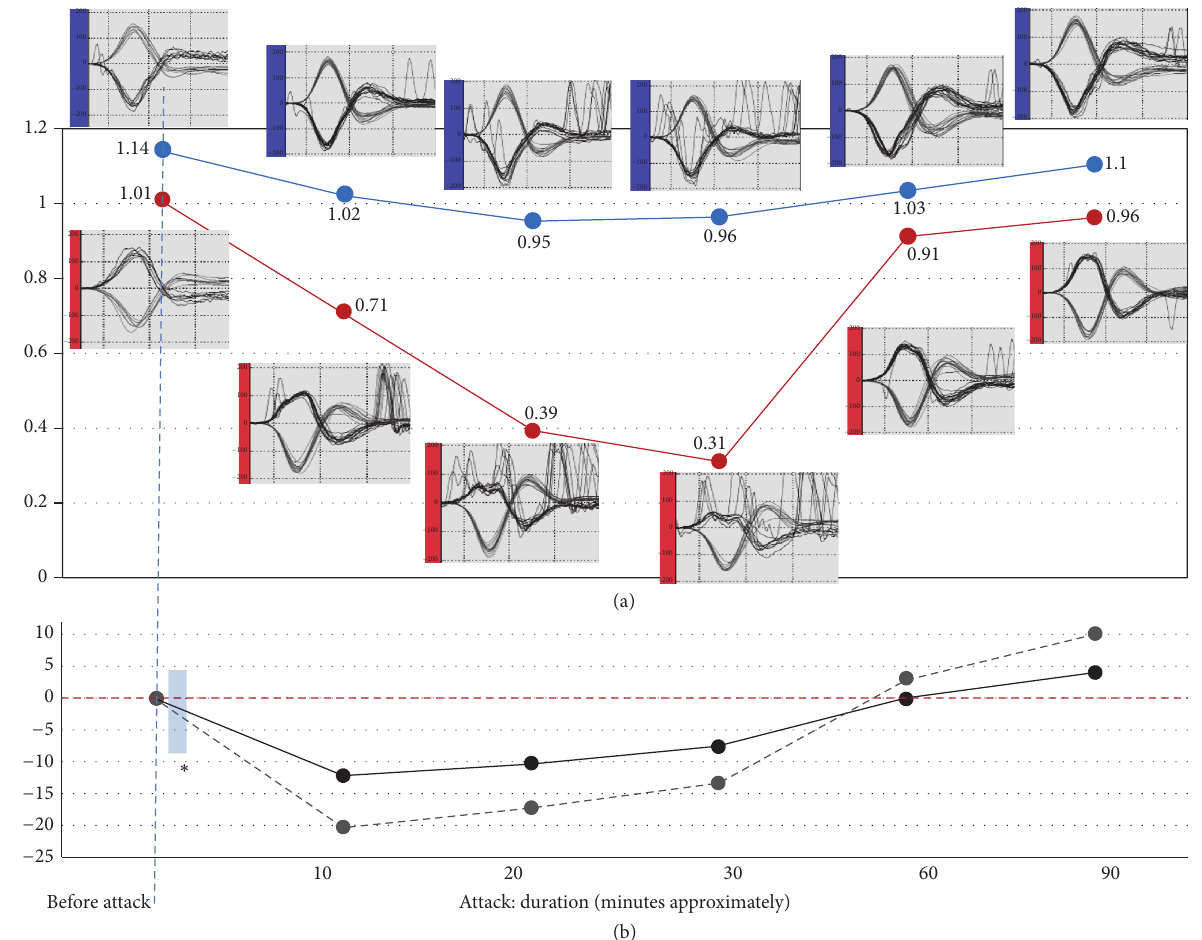
Figure 1: (a) The VOR regression gain values on the 𝑦 -axis shows evolution of the right affected side (red line) and left side (blue line) during a vertigo attack from the beginning (0 minutes before attack) to the symptomatic end (90 minutes). The small plots show the video Head Impulse Test (vHIT) recordings; the velocity trajectories ( ∘ /s) of the eye (dark grey lines) and head (light grey lines) are depicted during right and left impulses. There are short time mismatches between the vHIT records and the VNG records (spontaneous nystagmus), which can be attributed to the changes and calibration of each instrument. On the right HIT, note the saturated profile of the eye velocity curve and the low VOR gain (from 1.01 to 0.31) as well as the grouped, same direction corrective saccades (at 0.71 right gain). Note also that, with the progression of the attack (at 0.39 and 0.31 right gain), the untidy saccadic movements observed on the ocular velocity baseline trace are due to the interference effect at the onset of the fast phase of the spontaneous nystagmus. At the end of the acute stage (about 60 minutes), the horizontal nystagmus changes direction, and the eye velocity curve regains its normal trajectory, although the VOR gain still shows a slight asymmetry. A week later, the gain was normal (1.09 right and 1.1 left), and no corrective saccades or spontaneous nystagmus were recorded. Technical conditions of the vHIT: number of head impulses technically accepted for analysis: from 10 to 25. Head velocity: from 140 to 190 ( ∘ /sec). (b) Spontaneous nystagmus. Velocity SPV ∘ /sec on the 𝑦 -axis is shown with fixation (black line) and without fixation (grey line). At 60 minutes, the nystagmus reversed to the right. ∗ The irritative period was not